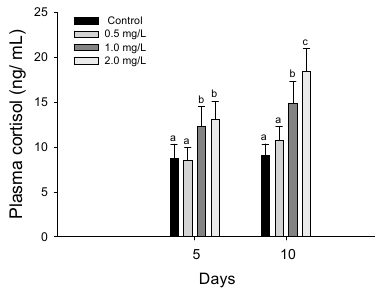
Figure 3. Plasma cortisol of flatfish, Paralichthys olivaceus, exposed to the different concentrations of waterborne chromium for 10 days. Values with different superscripts are significantly different in 5 and 10 days ( p < 0.05) as determined by Tukey’s multiple range test.